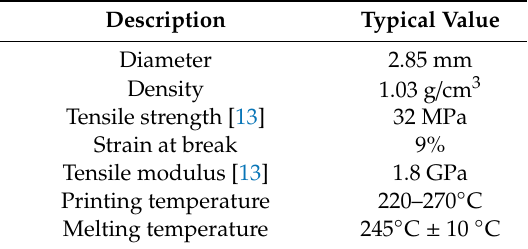
Table 1. Dimensions, physical and thermal properties of acrylonitrile–butadiene–styrene